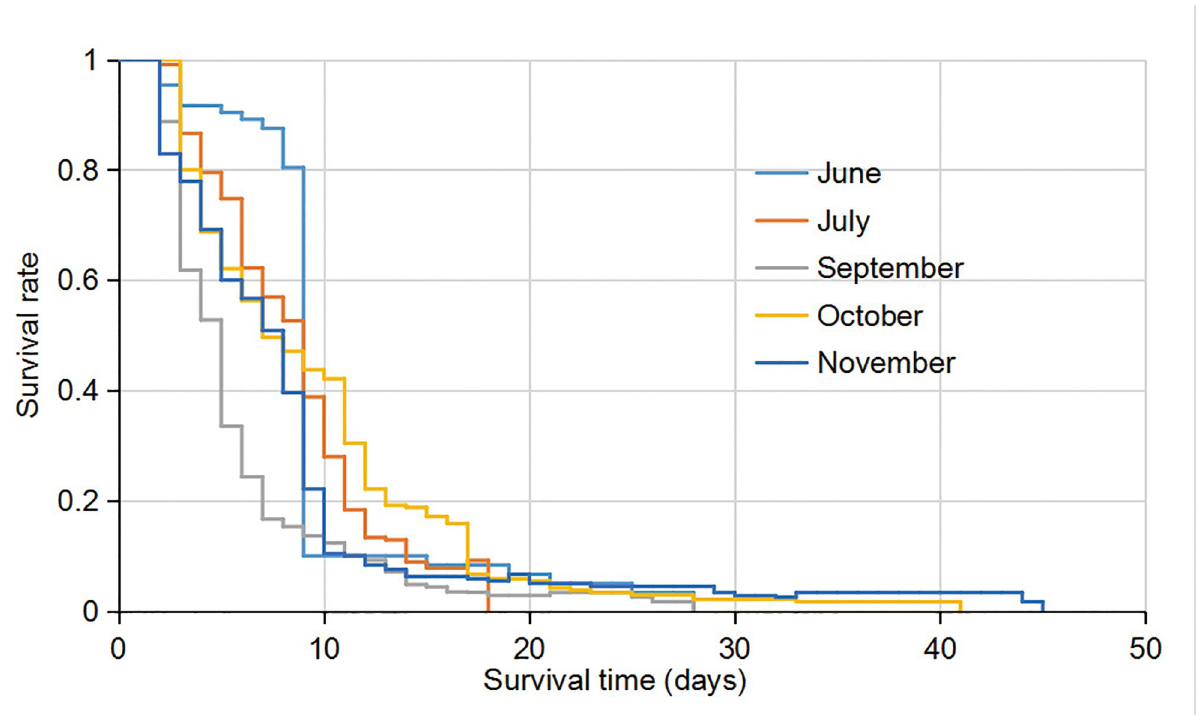
Fig 10. Kaplan-Meier survival curve of Ae . albopictus adults in different months. June-July experiments were conducted in semi-natural condition and September-November experiments were conducted in semi-field condition.